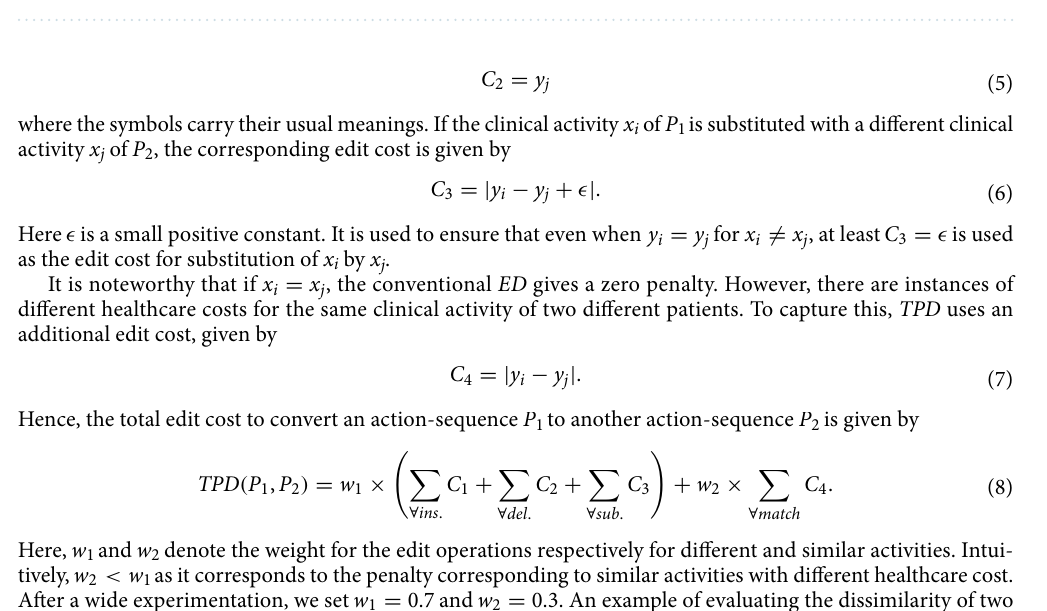
Figure 2. Calculation of TPD of two action